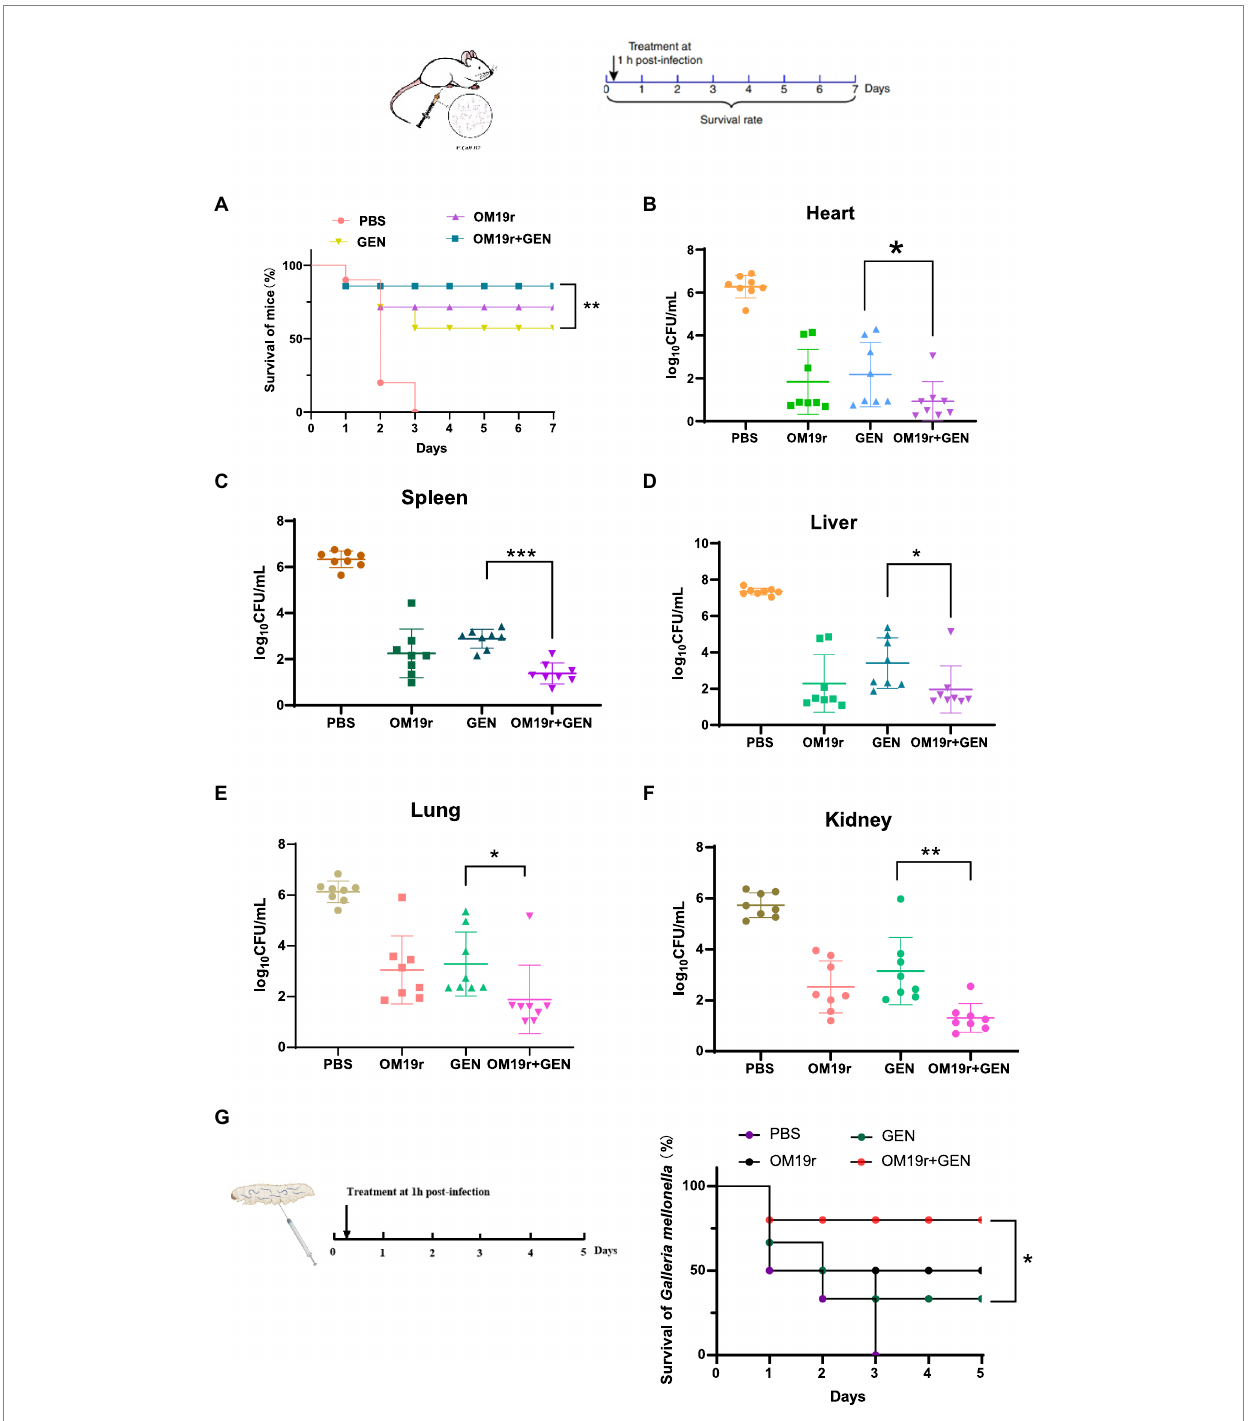
FIGURE 13 OM19r rescues GEN activity in two animal models of infection. (A) Survival curve of mice infected with non-lethal dose of E. coli B2 (3 × 10 8 cfu/ml) for 7 days. p -values determined using a two-sided log[rank] (Mantel-Cox) test. (B–F) Bacterial load in all organs (heart, spleen, liver, lung and kidney) of mice measured after OM19r combined with GEN treatment. G, Survival curve of G. mellonella larvae infected with a non-lethal dose of E. coli B2 (1× 10 5 cfu/ml) for 5 days. p-values determined using a two-sided log[rank] (Mantel-Cox)